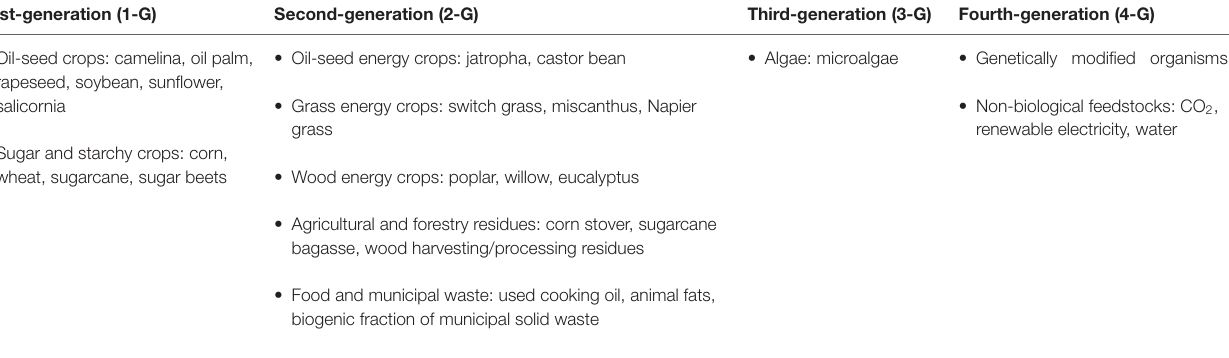
TABLE 3 | Feedstocks for bio-aviation fuel production (Rye et al., 2010; Warshay et al., 2011; Kandaramath Hari et al., 2015; ATAG, 2017; Chiaramonti Horta and Nogueira, 2017; Rödl, 2018; Roth et al., 2018; Staples et al., 2018; Alalwan et al., 2019). First-generation (1-G)